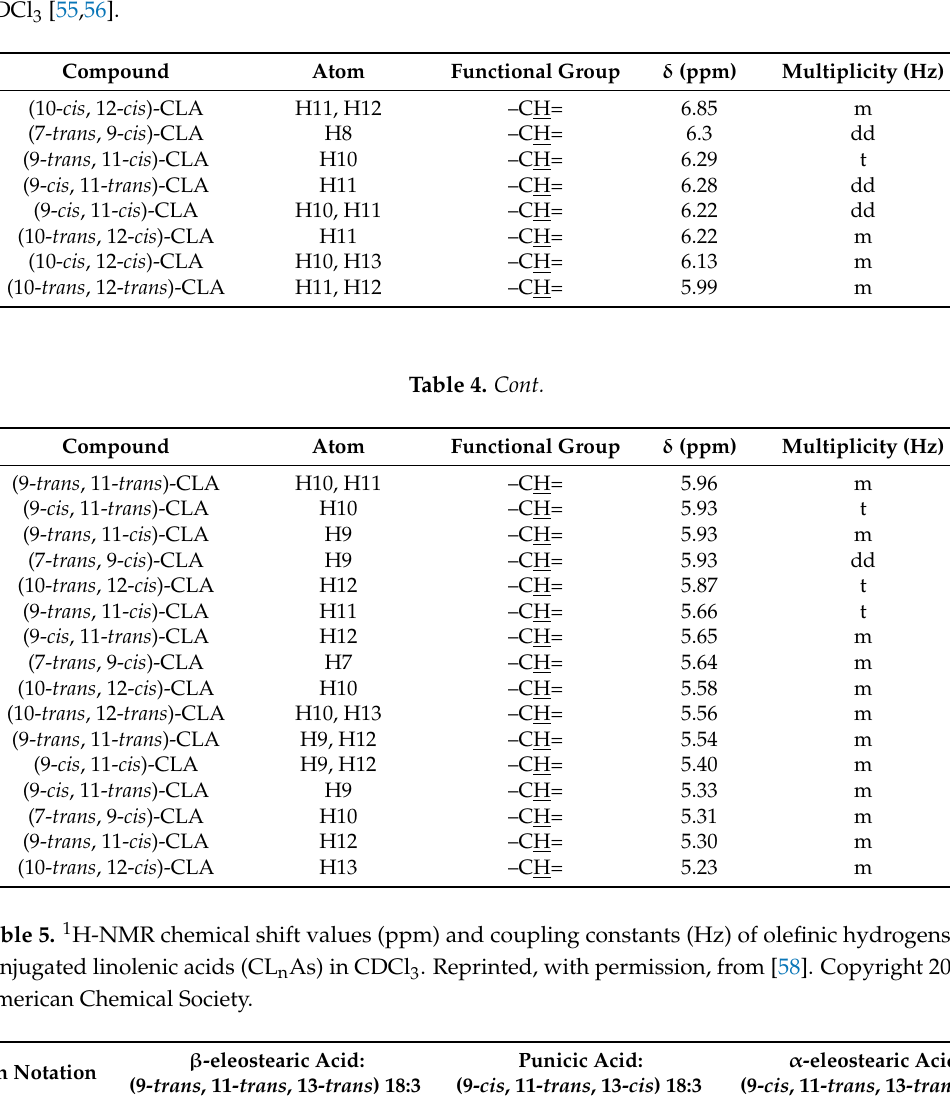
Table 4. 1 H-NMR resonance assignments of olefinic protons of conjugated linoleic acids (CLAs) in CDCl 3 [55,56].